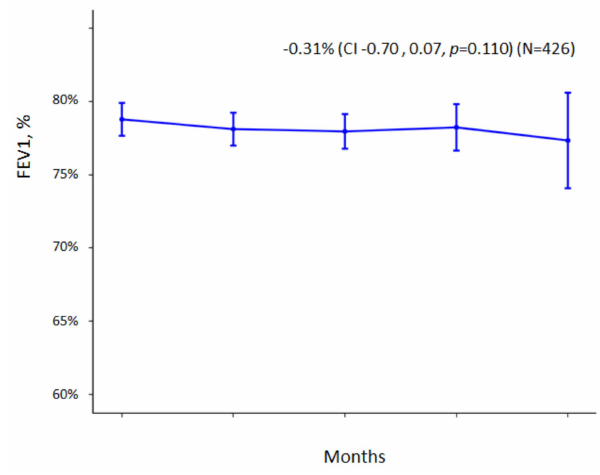
Figure 2. FEV1% decrease in the total group of patients included in the study (n = 426) ( p = 0.110). FEV1: Forced expiratory volume one second; CI: Confidence interval.